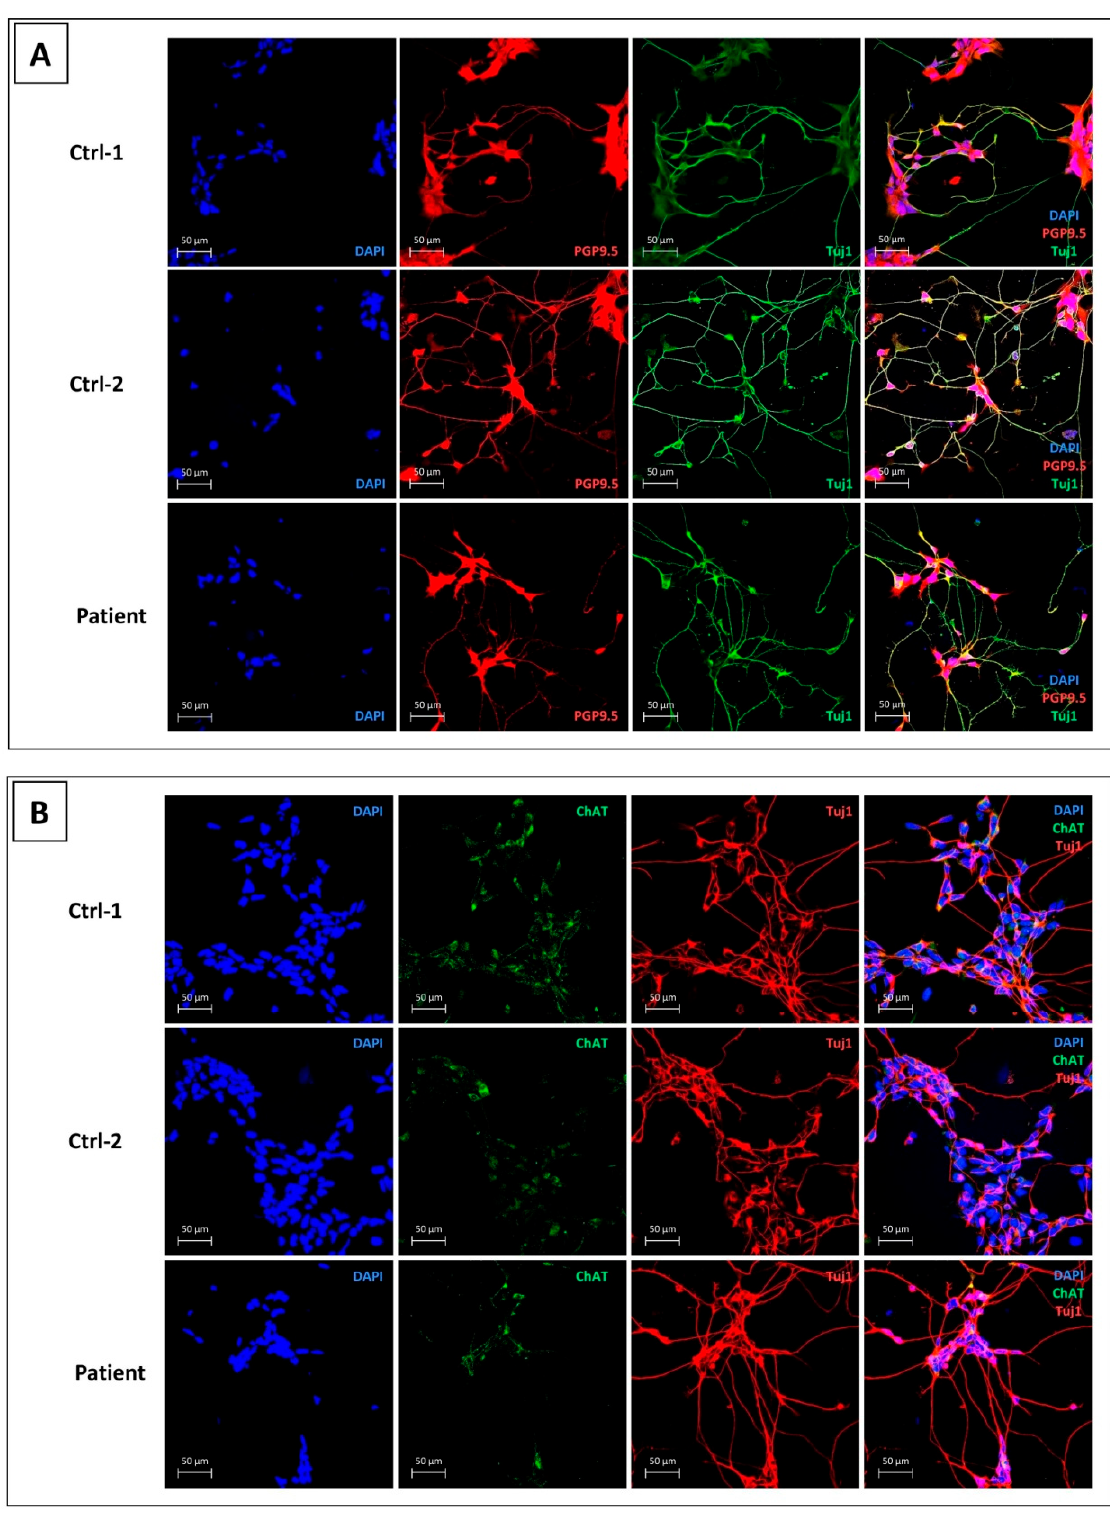
Figure 2. Characterization of hiPSCs-derived motor neurons, for Ctrl-1, Ctrl-2, and patient. ( A ) DAPI (blue) for nuclei staining, PGP9.5 (red), and β -tubulin III (Tuj1) (green); ( B ) DAPI (blue) for nuclei staining, choline acetyltransferase (ChAT) (green) and β -tubulin III (Tuj1) (red). Scale bar = 50 µm.